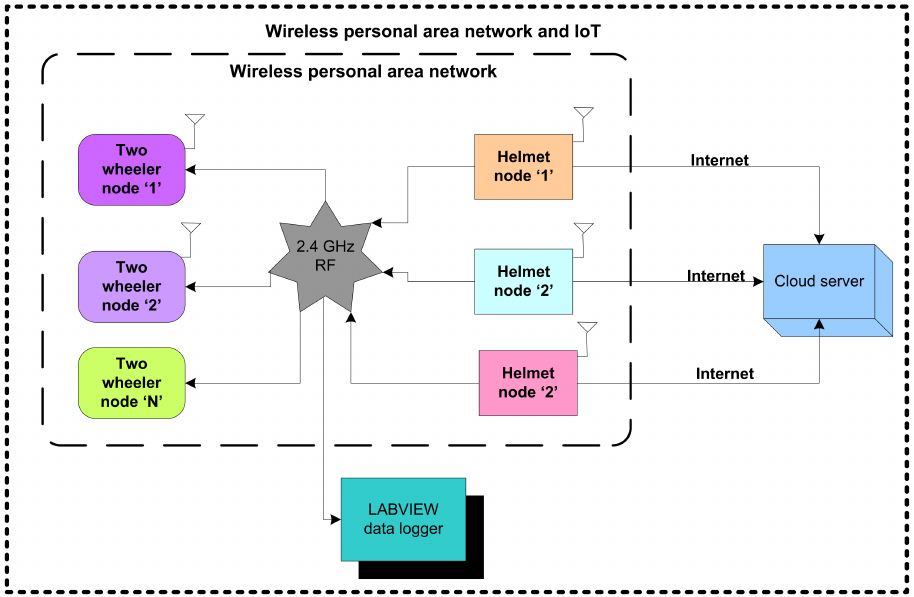
Figure 1. WPAN and IoT-based